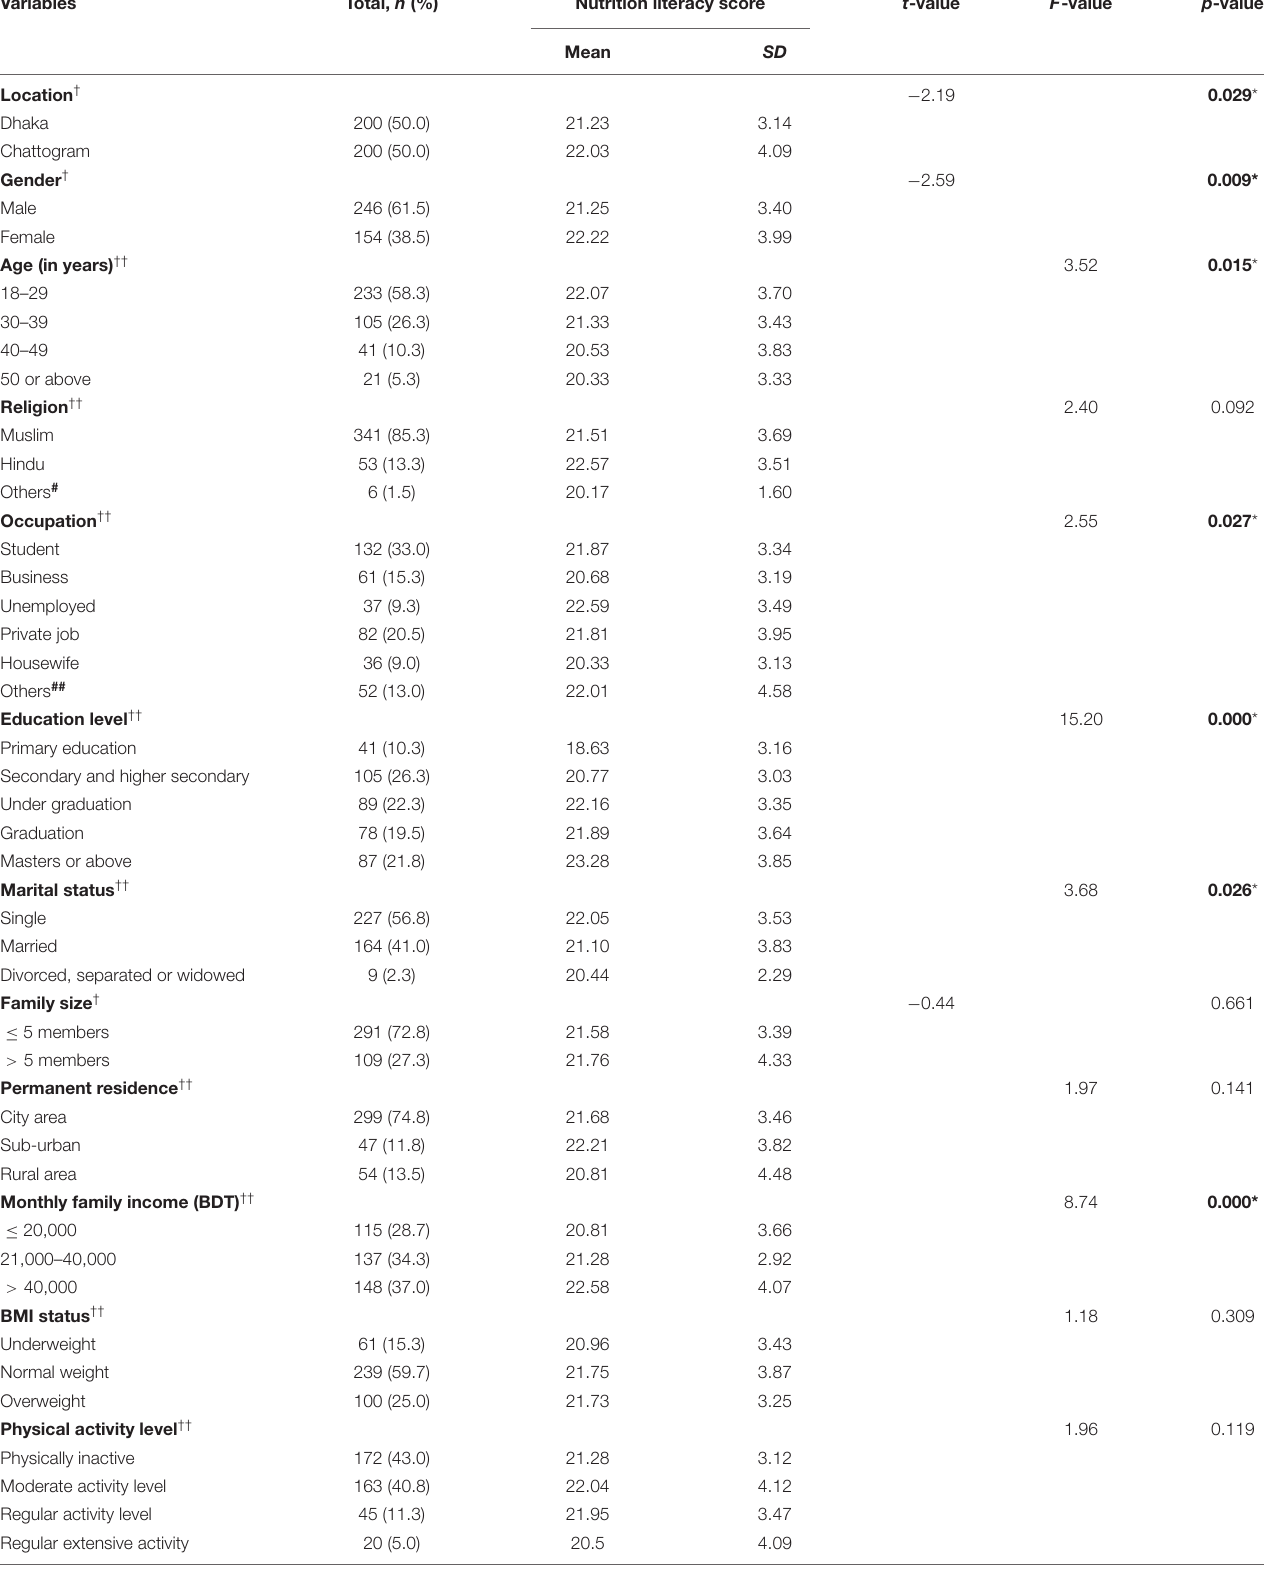
TABLE 1 | Participants’ characteristics and distribution of nutrition literacy score across different categories ( N = 400). Variables Total, n (%) Nutrition literacy